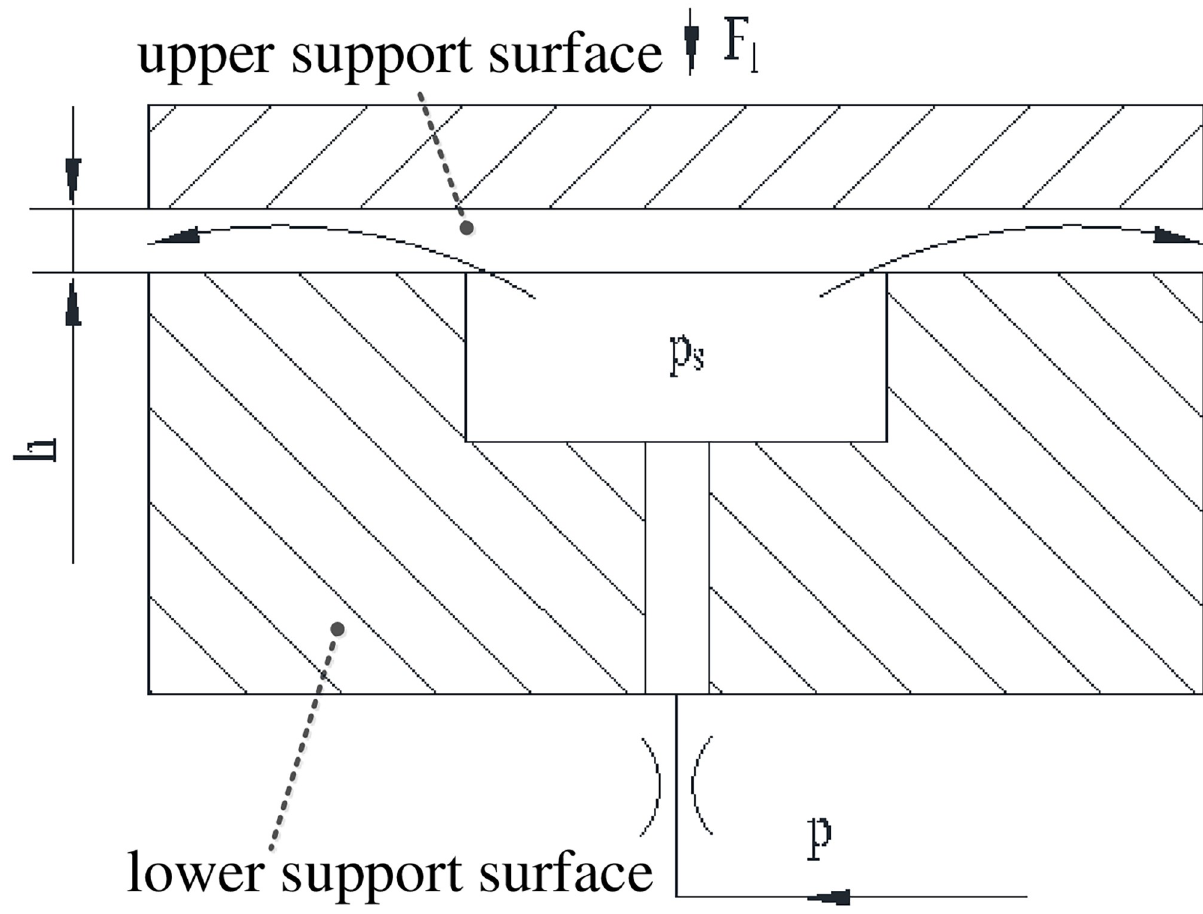
Fig 1. Typical structure of hydrostatic